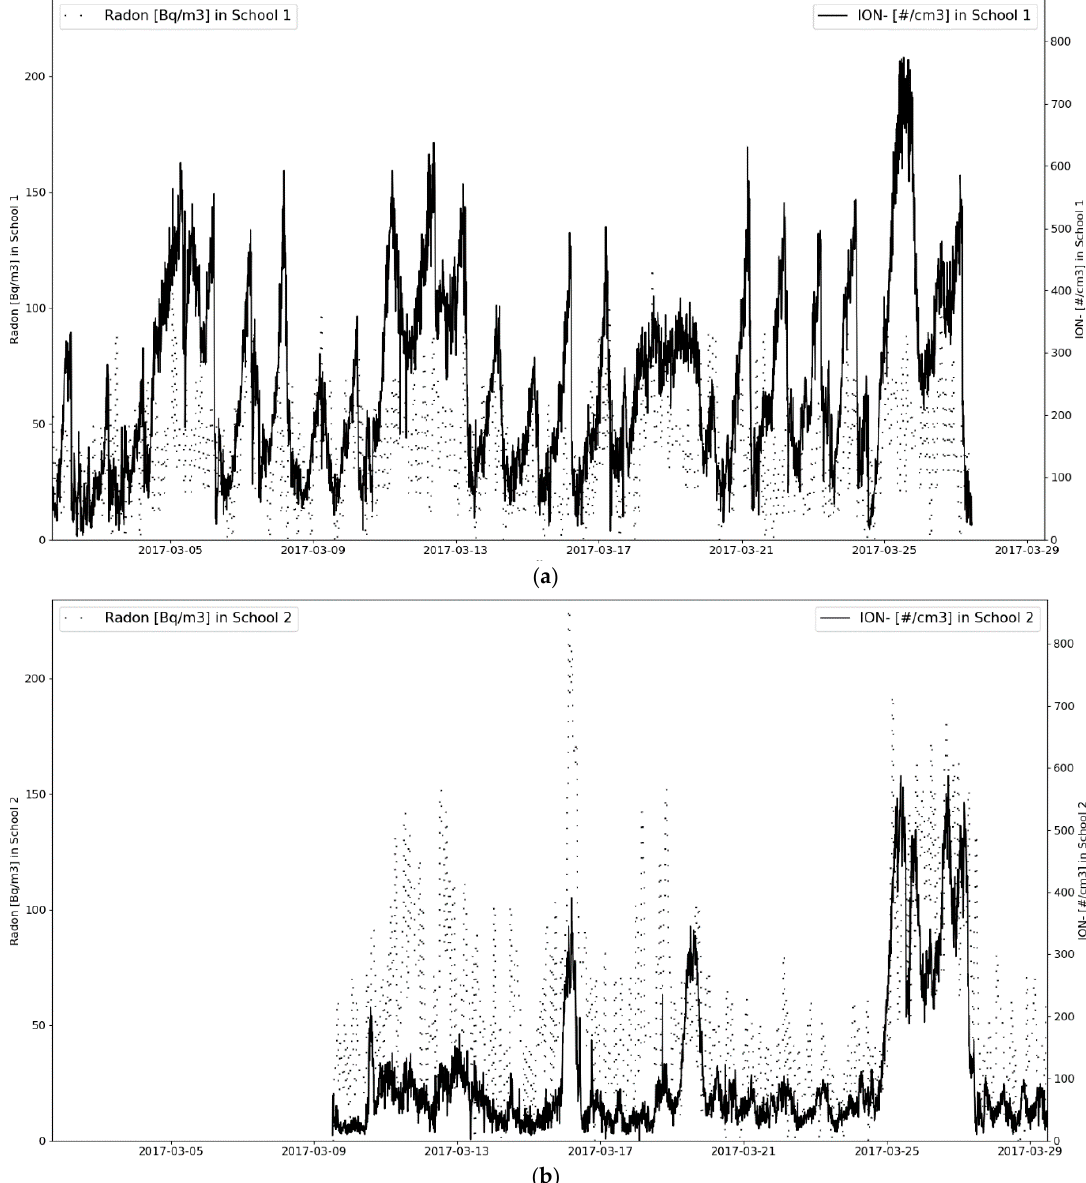
Figure 2. Radon concentration (dotted) vs. small ion concentration (full line) in ( a ) School 1 and ( b ) School 2.